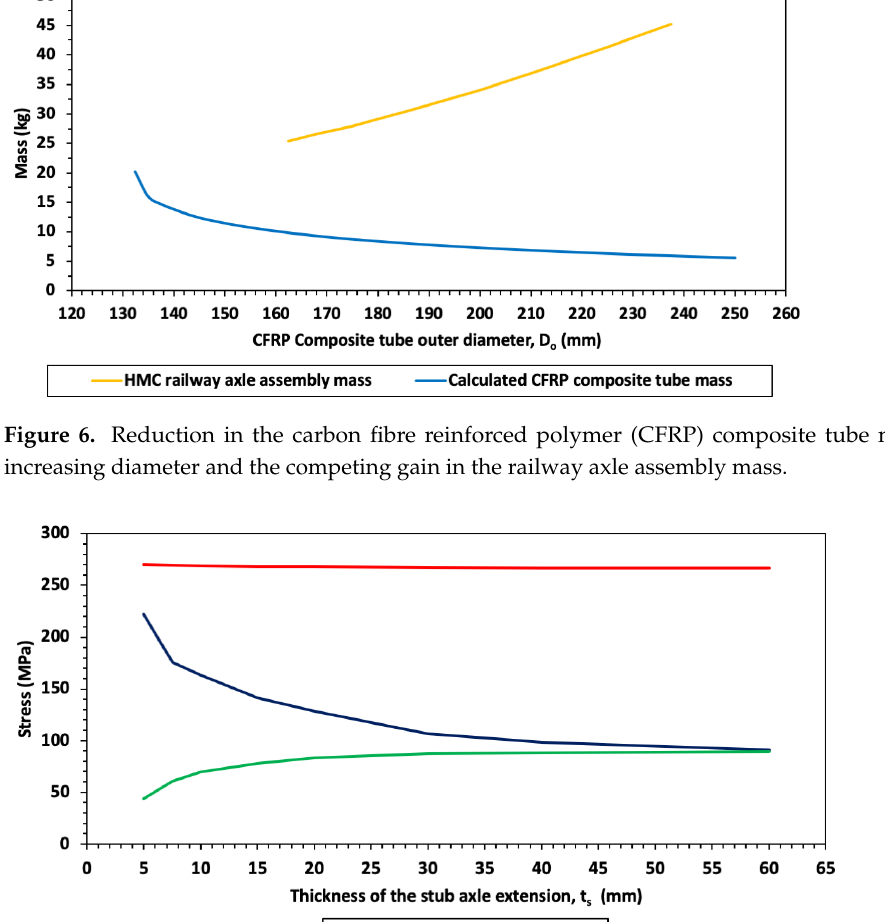
Figure 6. Reduction in the carbon fibre reinforced polymer (CFRP) composite tube mass with in- creasing diameter and the competing gain in the railway axle assembly mass.